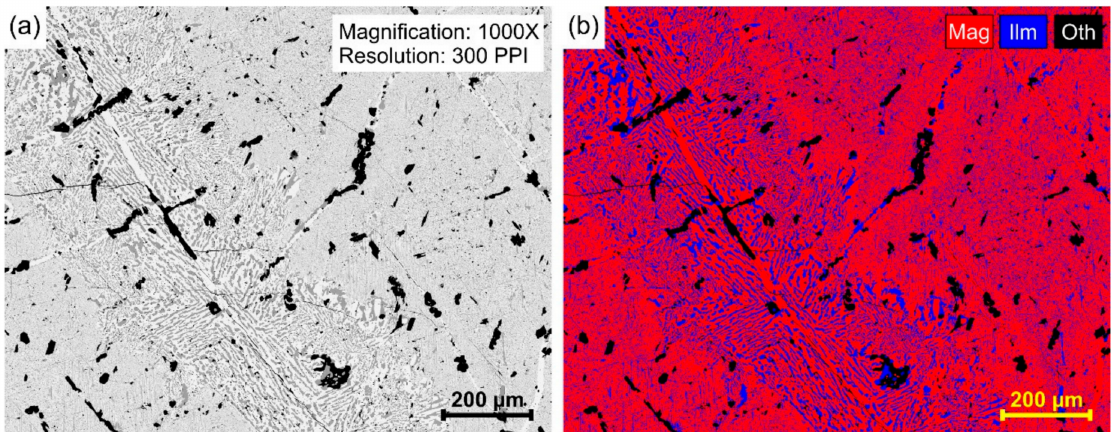
Figure 3. An example of ( a ) a high-resolution backscattered electron image (1000X) that was acquired on a Zeiss EVO-MA15 SEM, and ( b ) the corresponding false-color image showing the distribution of ilmenite exsolutions in decomposed titanomagnetite ss . See text for details. Ilm, ilmenite; Mag, magnetite; Oth,